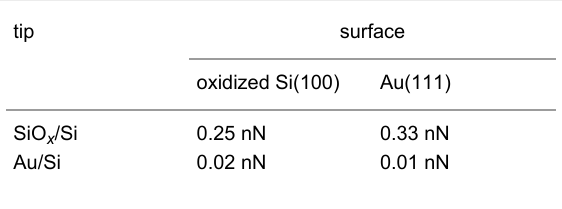
Table 2: Friction values for intact tips sliding against non-reactive sur-